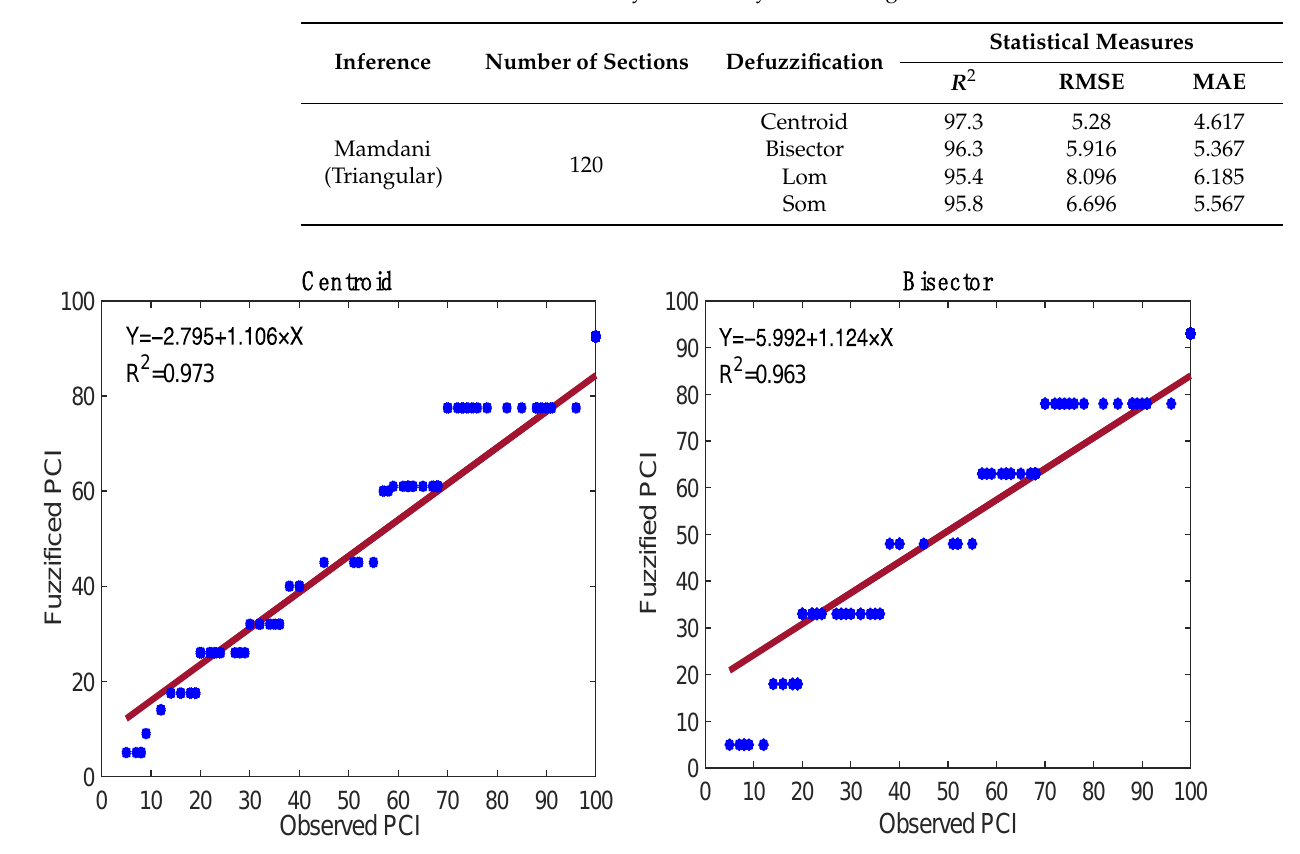
Table 4. Assessment various fuzzy inference systems’ configurations for 120 sections.